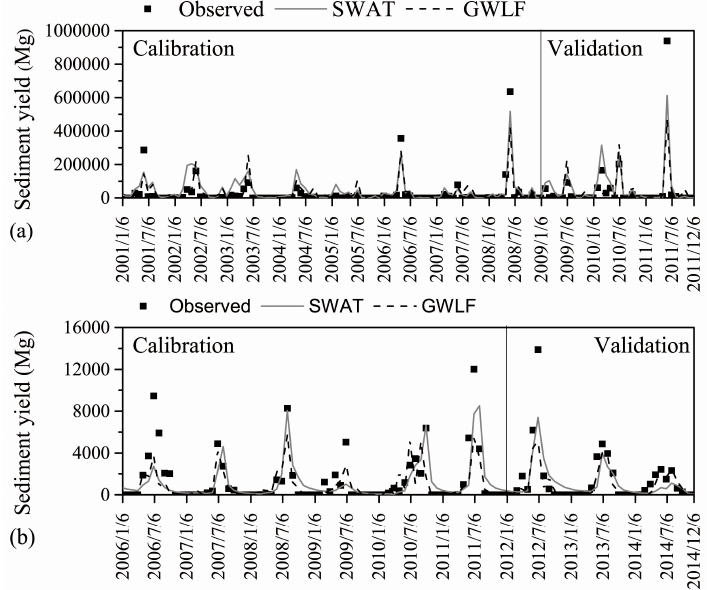
Figure 4. Simulated and observed monthly sediment yield for the: ( a ) Tunxi watershed; and ( b ) Hanjiaying watershed.